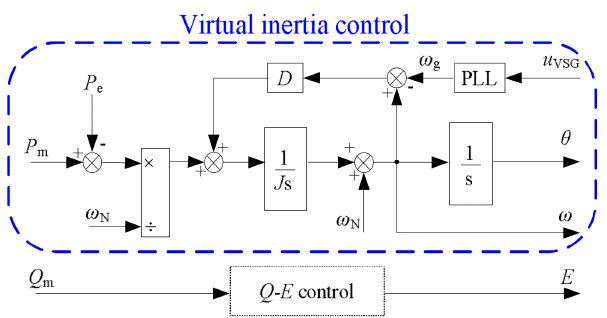
Figure 14. Control block diagram of